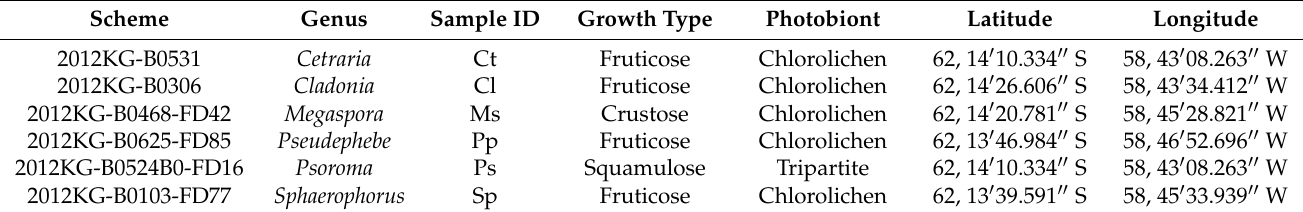
Table 1. Information on the lichen specimens used in this